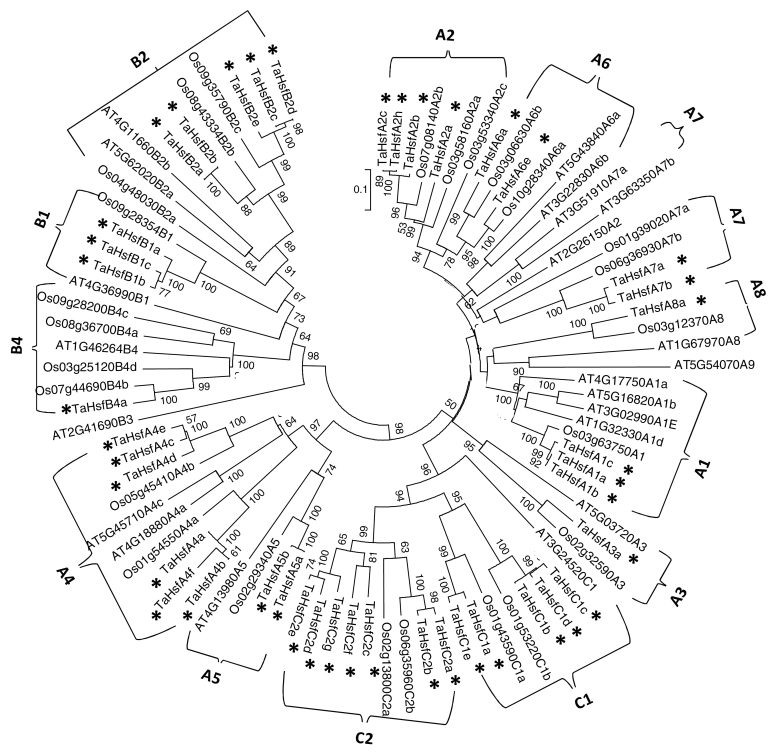
The Neighbor–Joining phylogenetic tree of Hsf proteins from wheat, rice, and Arabidopsis. The N-proximal regions (from the start of the DNA-binding domain to the end of the HR-A/B region) of Hsf proteins were used for construction of the phylogenetic tree using the MEGA 5.10 program. Unrooted Neighbor–Joining analysis was performed with pairwise deletion and Poisson correction. For rice (prefixed by Os) and Arabidopsis (prefixed by AT) Hsf proteins, both locus ID and subclass number were used (e.g. AT4G17750A1a=AtHsfA1a with a locus ID AT4G17750). TaHsf proteins are marked with asterisks. Bootstrap values >50 are shown.